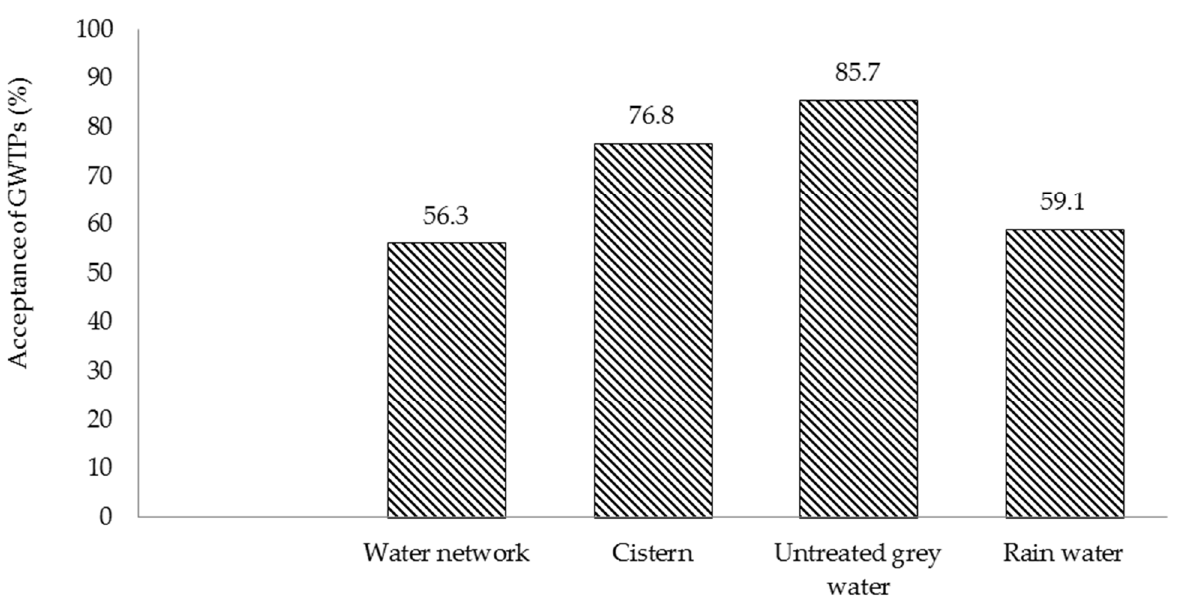
Figure 5. Acceptances of GWTPs relative to water source of irrigation.